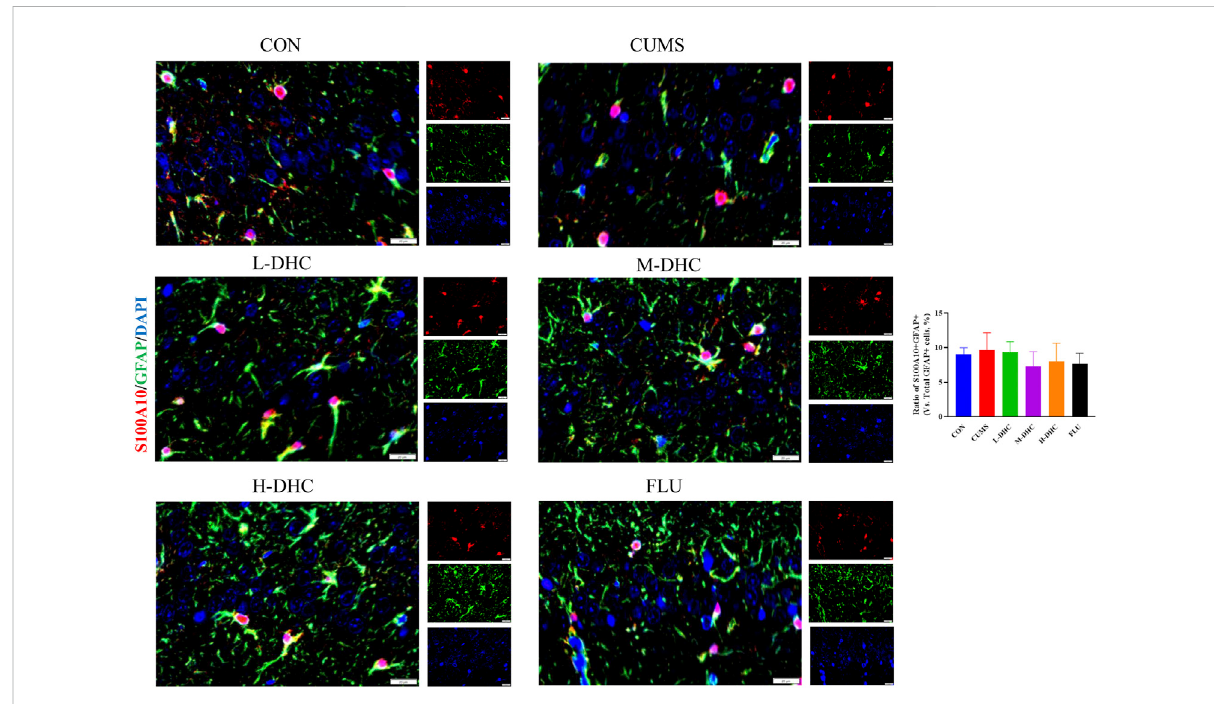
FIGURE 7 Effects of DHC or fl uoxetine on A2 astrocyte activation in CUMS-induced depression in mice. Red fl uorescence represented S100A10 positive cells, and green fl uorescence represented GFAP positive